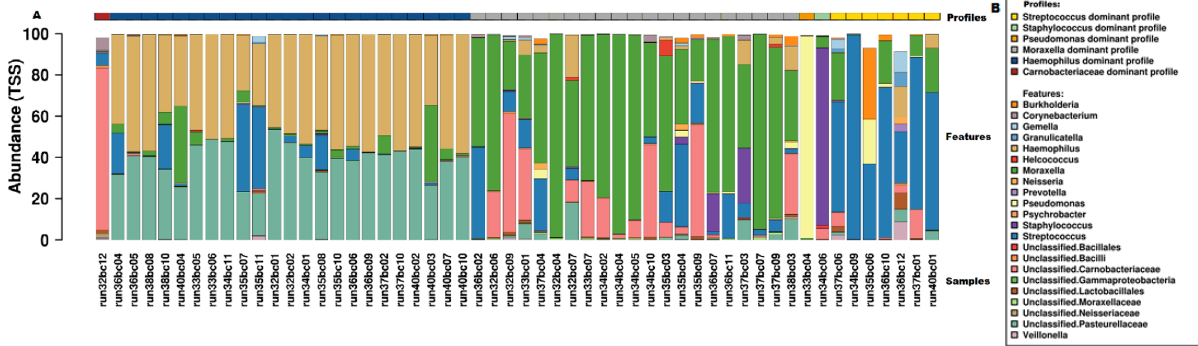
Figure 2. Microbiome profiles of samples presented as relative genus abundance. ( A ) Bar chart of individual samples, displaying the relative abundance on genus level for the top 20 genera. Individual samples are presented as run numbers and the corresponding microbiome profile is presented by colored bars at the top of the figure. ( B ) Legend for figure A.